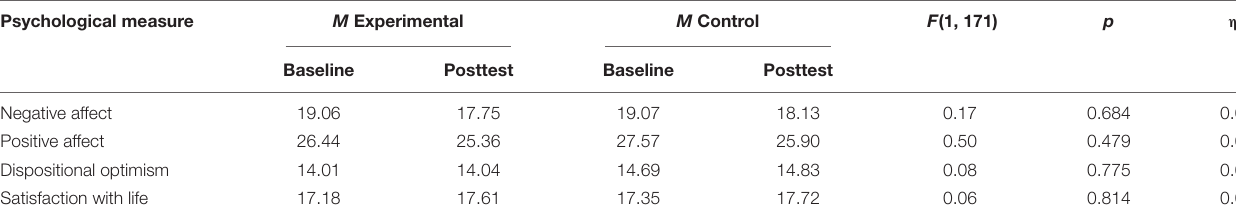
Dispositional optimism Satisfaction with life